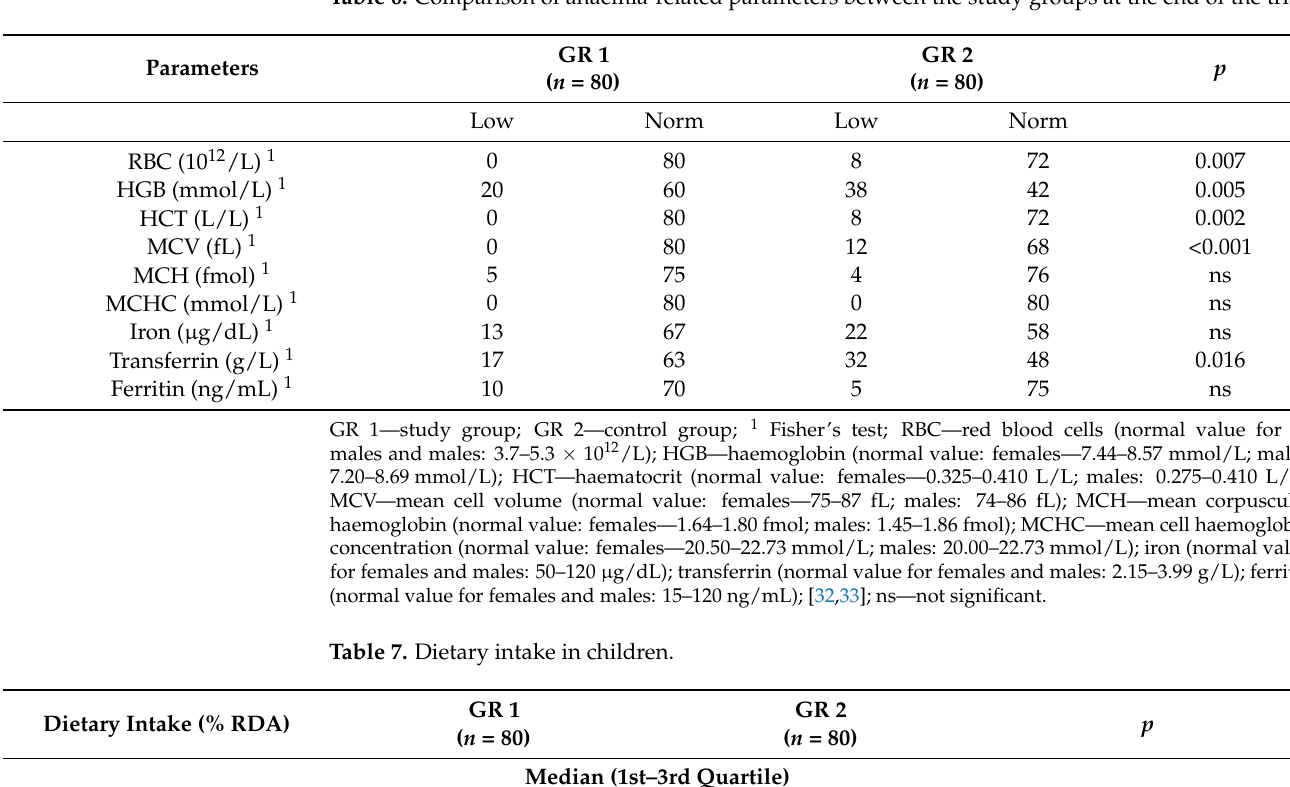
Table 6. Comparison of anaemia-related parameters between the study groups at the end of the trial.